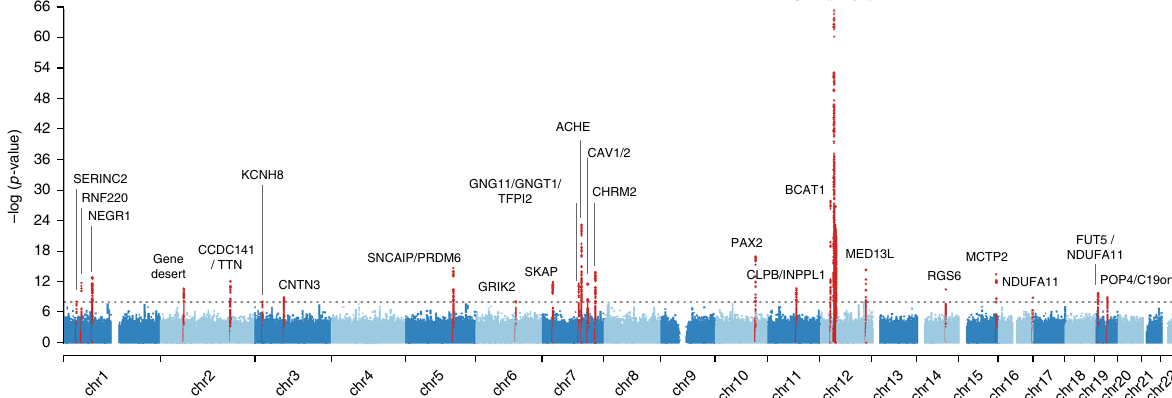
Fig. 2 Manhattan plot of the GWAS of HR increase and recovery. The smallest p -values per SNP across all of the six studied traits are shown, as depicted on the y -axis, the x -axis shows their chromosomal (chr) positions. Red dots represent genome-wide signi fi cant loci ( p < 8.3 × 10 − 9